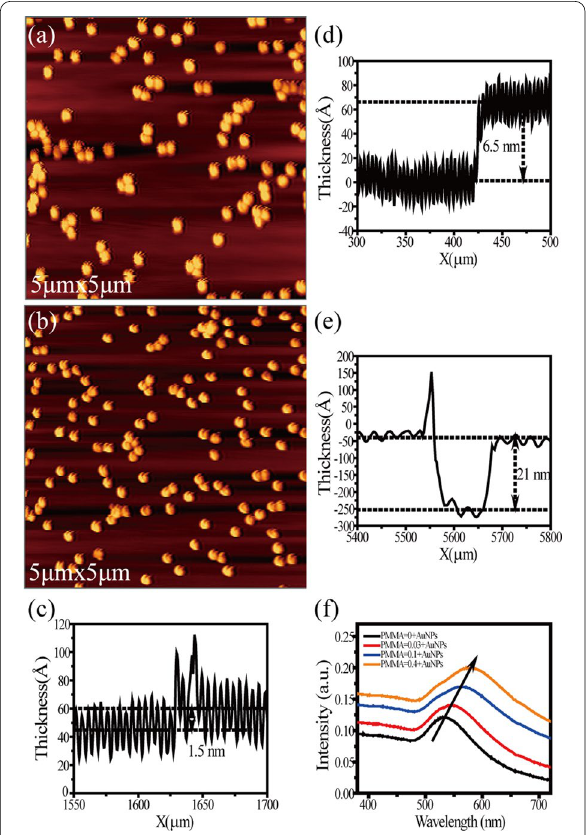
Fig. 2 Typical AFM images of Au NPs/glass ( a ) and PMMA/Au NPs/ glass ( b ). Surface profile of PMMA films with concentrations of 0.03wt% ( c ), 0.1wt% ( d ) and 0.4wt% ( e ). f UV–Vis absorption spectra of the NPs without PMMA (black) and with 1.5-nm (red), 6.5-nm (blue) and 21-nm (orange) PMMA separation layer